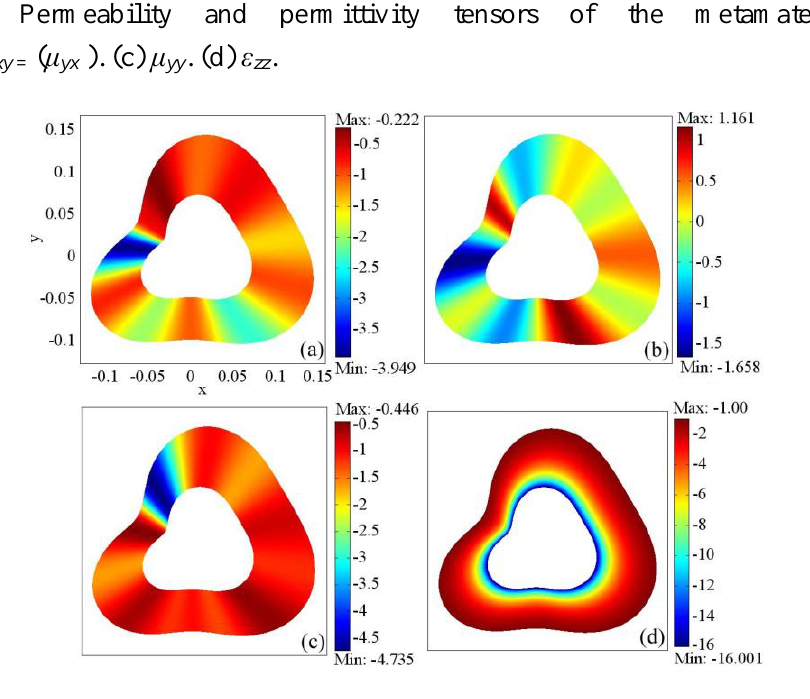
Figure 2. Permeability and permittivity tensors of the metamaterial